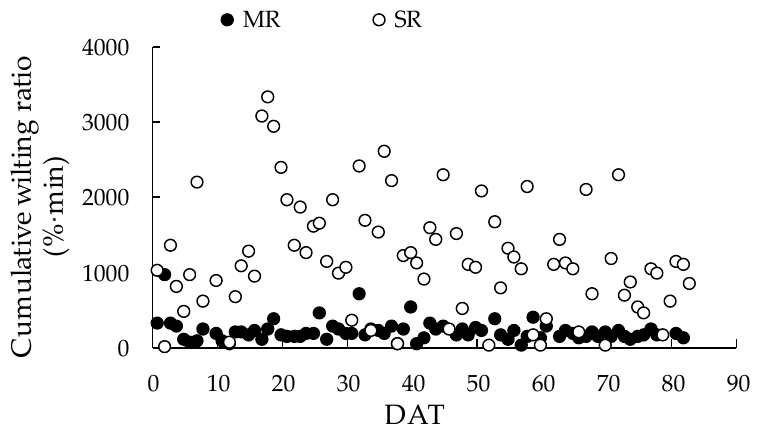
Figure 4. Cumulative wilting ratio during the treatment period. The cumulative wilting ratio was calculated using the sum of W per minute higher than 4% during the 10 h from 07:00 to 17:00. DAT: days after commencing treatments; MR: moderate wilting–full recovery treatment; SR: severe wilting–full recovery treatment. Table 1. Total irrigation amount and frequency during an 83-day treatment period. Treatment